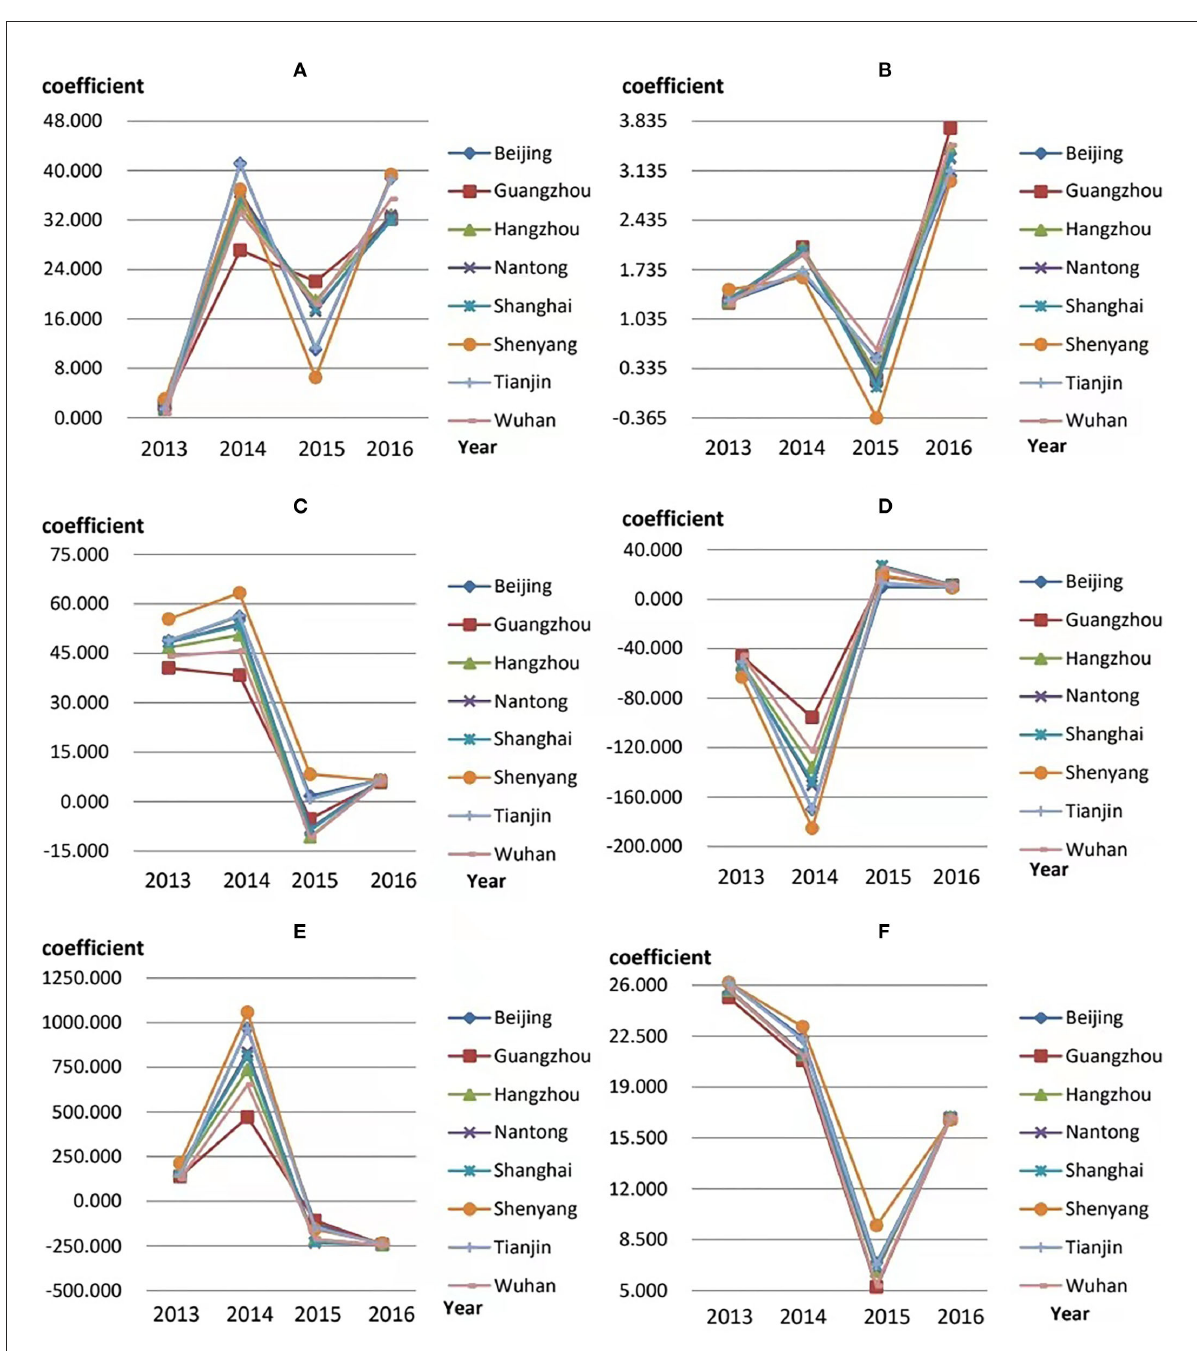
FIGURE2 Temporal variation in the estimated coefficients. (A–F) represent the coefficient variations of LAN, PM2.5, per capita consumption expenditure, economic density, population density, and number of medical beds,